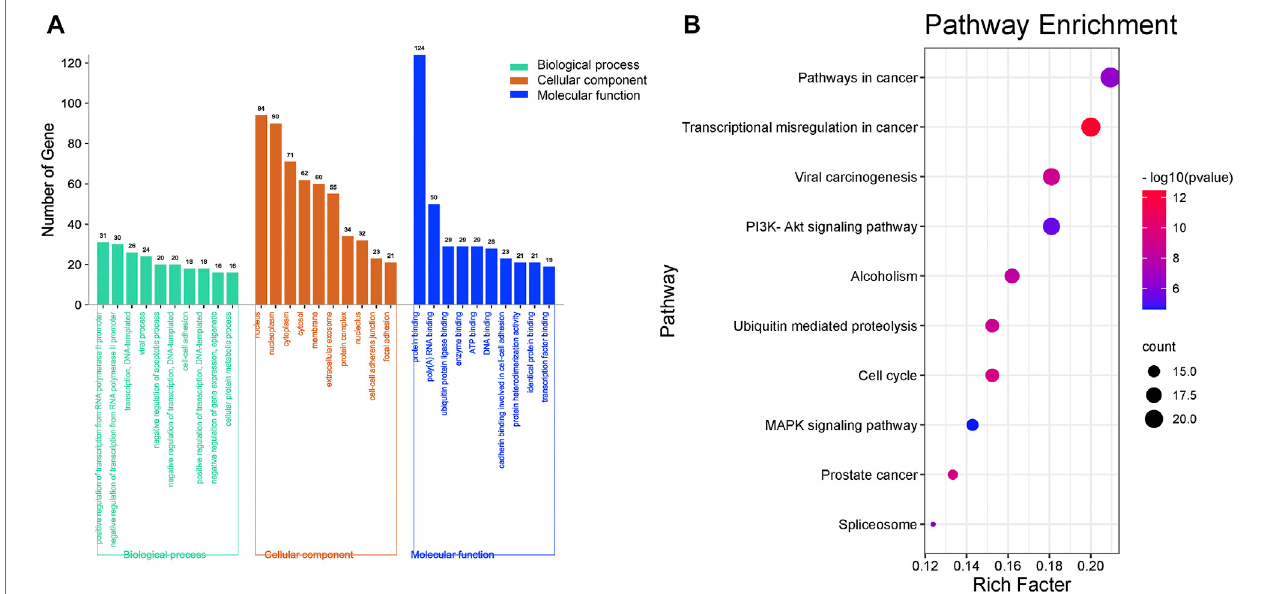
FIGURE4 | Enrichment ofGO and KEGG analysisof the 126key genestargeted byRC against MI. (A) TheGOenrichmentresults ofbiological processes, cellular components, and molecular function. (B) Enriched KEGG pathways of potential key targets. The top 10 major enriched pathways are